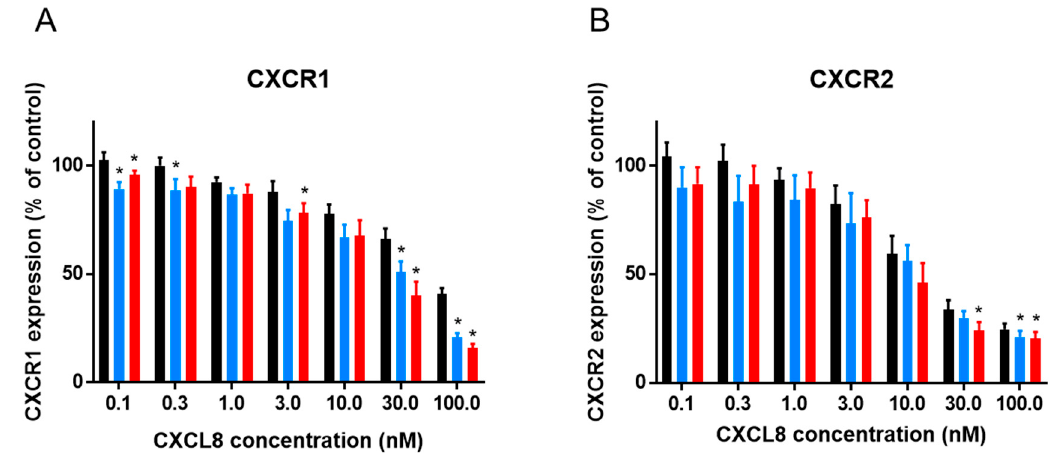
Figure 1. Effects of NH 2 -terminal processing on CXCL8-induced receptor internalization. Flow cytometry was used to determine CXCR1 ( A ) and CXCR2 ( B ) expression levels on freshly purified neutrophils that were stimulated with the indicated concentrations of CXCL8(1-77) (black bars), [Cit5]CXCL8(1-77) (blue bars) or CXCL8(6-77) (red bars) during 1 h. Results are represented as relative receptor expression levels (compared to buffer treated control cells) ± SEM ( n = 6) after stimulation with the indicated concentrations of CXCL8 forms. Wilcoxon matched pairs test were performed to calculate whether stimulation with [Cit5]CXCL8(1-77) or CXCL8(6-77) induced a significantly different response compared to stimulation with native CXCL8(1-77). * p < 0.05 compared to